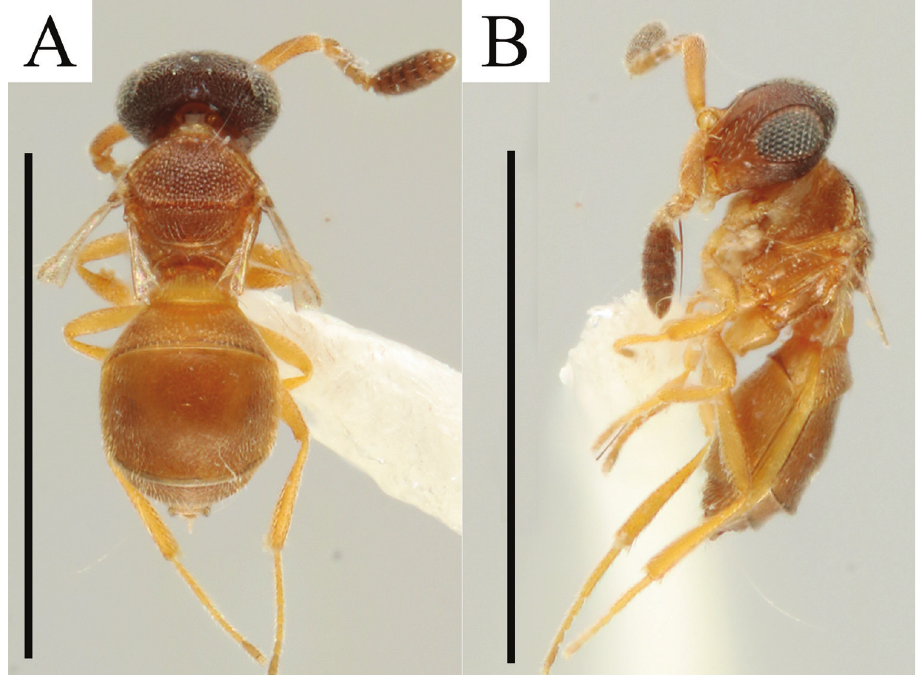
Figure 1. Trimorus coriaceus sp. n. A female, dorsal view B female, lateral view. Scale bars: 1 mm.